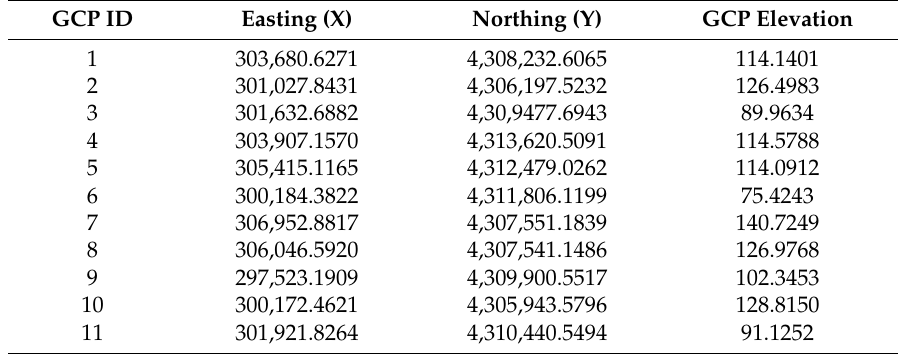
Table 2. GCPs used as control in SfM model development for historic aerial images. Elevation values were derived from a 3m DTM created from the 2008 lidar point